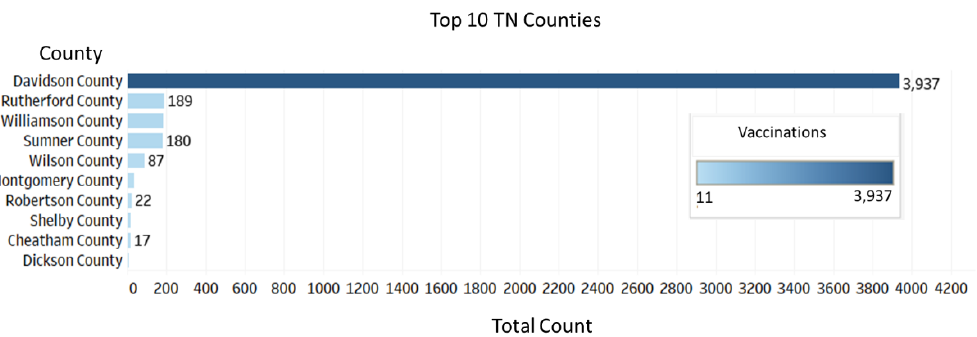
Figure 3. Number of vaccines distributed by the Meharry Medical College-Mobile Vaccination Program in the top 10 counties in Tennessee.